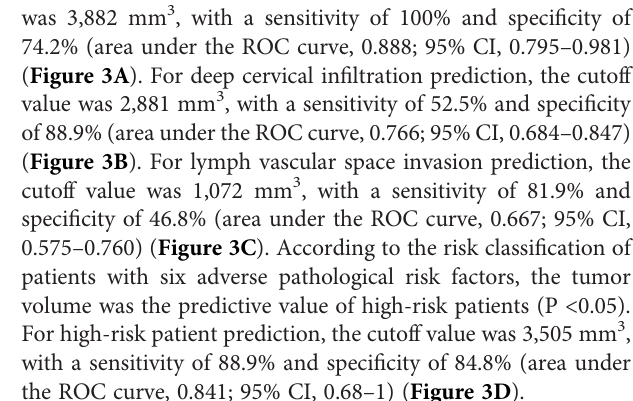
was 3,882 mm 3 , with a sensitivity of 100% and speci fi city of 74.2% (area under the ROC curve, 0.888; 95% CI, 0.795 – 0.981) ( Figure 3A ). For deep cervical in fi ltration prediction, the cutoff value was 2,881 mm 3 , with a sensitivity of 52.5% and speci fi city of 88.9% (area under the ROC curve, 0.766; 95% CI, 0.684 – 0.847) ( Figure 3B ). For lymph vascular space invasion prediction, the cutoff value was 1,072 mm 3 , with a sensitivity of 81.9% and speci fi city of 46.8% (area under the ROC curve, 0.667; 95% CI, 0.575 – 0.760) ( Figure 3C ). According to the risk classi fi cation of patients with six adverse pathological risk factors, the tumor volume was the predictive value of high-risk patients (P <0.05).